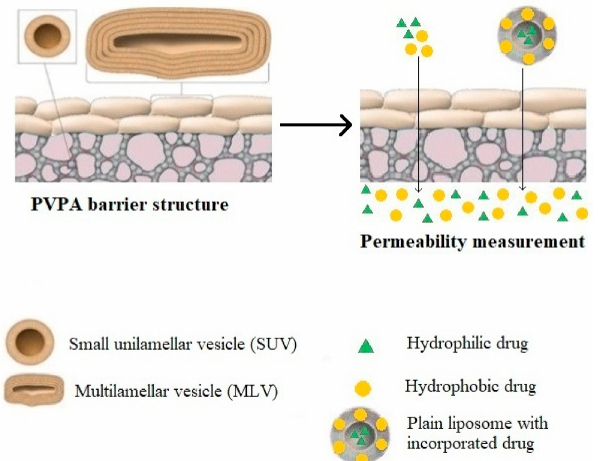
Figure 2. The phospholipid vesicle-based permeation assay (PVPA), mimicking the stratum corneum. It consists of a tight barrier of liposomes deposited on a cellular ester filter